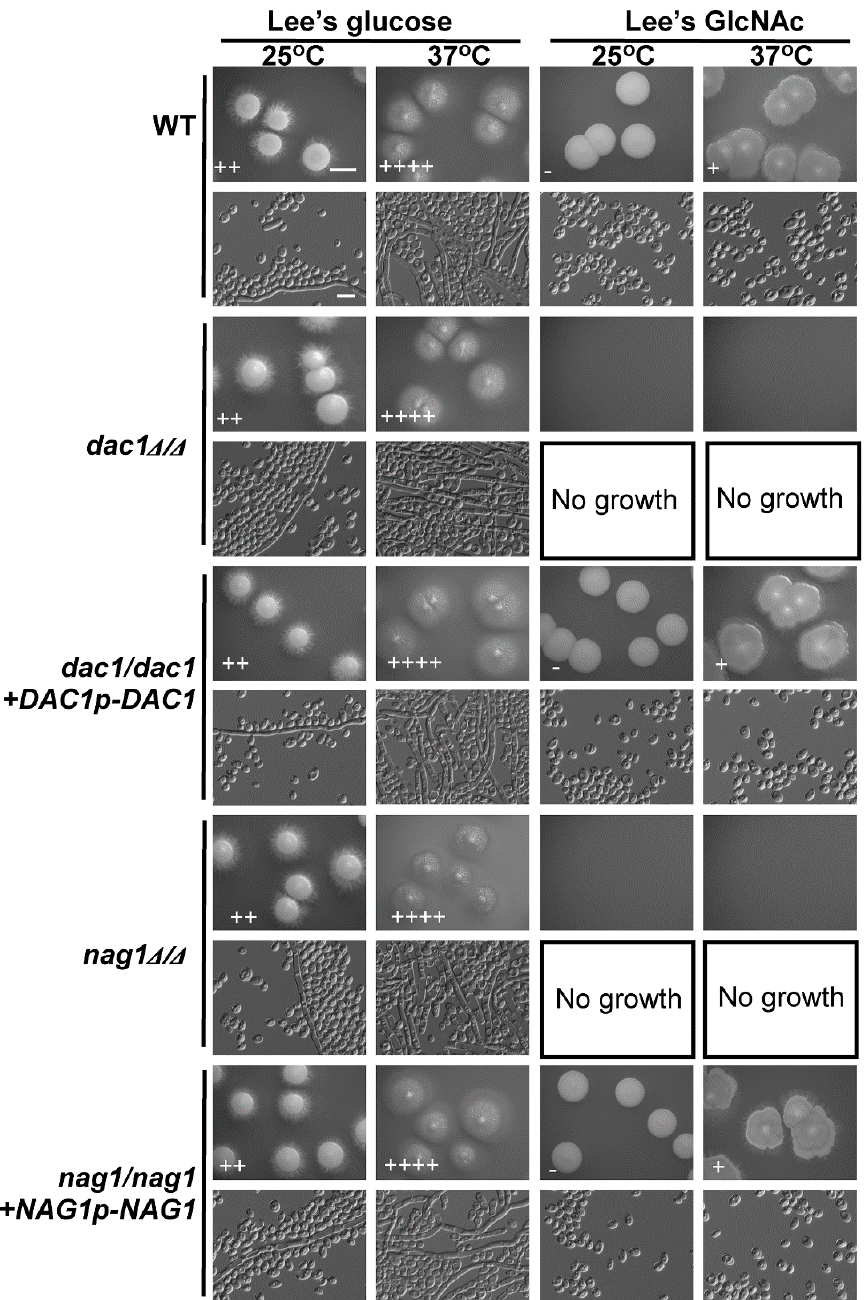
Figure 6. GlcNAc suppresses dac1 Δ / Δ and nag1 Δ / Δ cellular growth. WT, dac1 Δ / Δ mutant, dac1 Δ / Δ + DAC1p - DAC1 reconstituted strain, nag1 Δ / Δ mutant, and nag1 Δ / Δ + NAG1p-NAG1 reconstituted strain cells were plated on Lee’s agar plates containing glucose or GlcNAc, and after 6 days at 25 °C or 37 °C representative colony and cellular morphology was assessed. Five individual transformants for each gene were used for filamentous growth assays. The degree of hyphal growth is represented by “+” signs, with the percentages of filamentous cells being indicated as follows: +, 0.1%–5%; ++, 5%–20%; +++, 20%–40%; ++++, 40%–60%. If no hyphal growth was evident, “ - “ was instead used to indicate cells (< 0.1%). Scale bars for colonies and cells were 2 mm and 10 μ m, respectively. Scale bars for colonies and cells were 2 mm and 10 μ m, respectively.